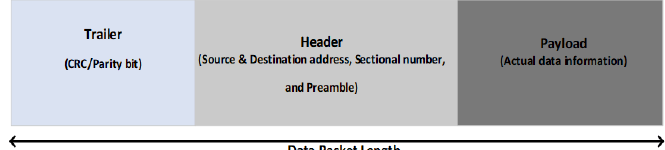
Figure 3. Packet Length